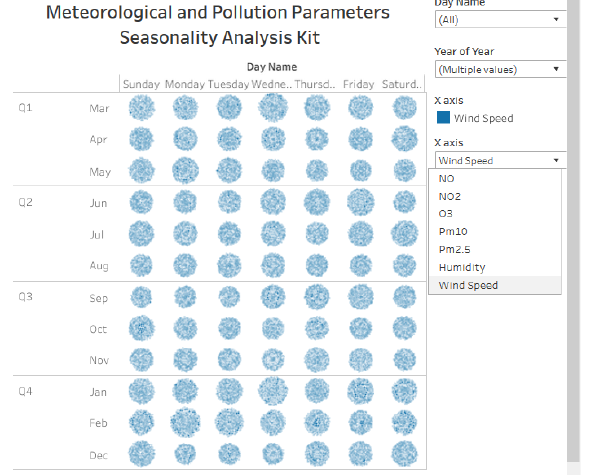
Figure 13: Interactive dashboard for meteorological and pollution parameters.